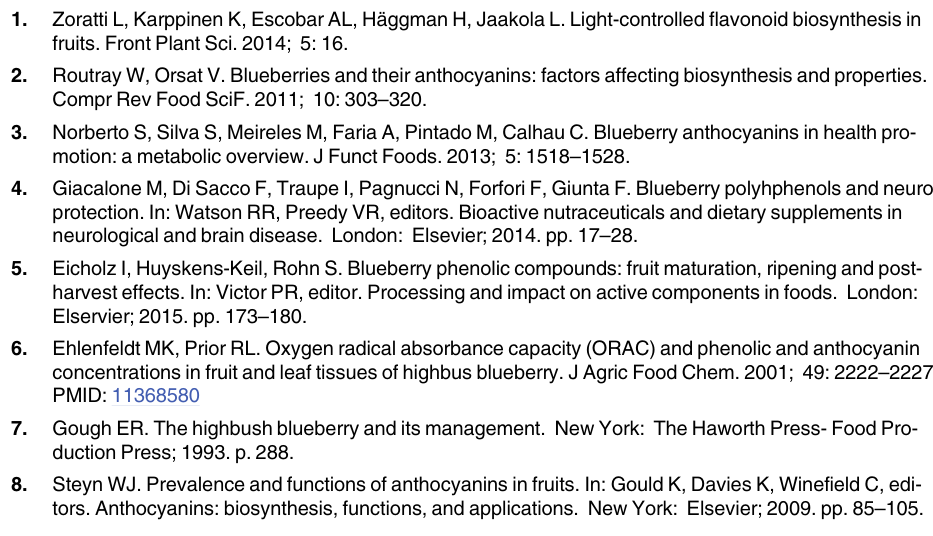
S2 Table. Light measurements taken at the top of the canopy every 2 nd hour between 9am and 3pm during the ripening period of berries (June 30, 2013). Measurements were done on clear sky sunny day. The quality of light reaching the plants was identified measuring the pho- tosynthetic active radiation (PAR; Photons/cm²/s) values between 200 – 850 nm for full light spectra, 280 – 320 nm for UVB, 280 – 380 nm for UVA, 380 – 495 nm for blue (B), 495 – 590 for green (G), 590 – 710 nm for red (R) and 710 – 750 nm for far-red (FR) components of the sun- light spectra. The ratios of B/R and R/FR were also calculated. S3 Table. Pomological analyses (single berry weight, diameter and height), total soluble solid content (TSSC) and acidity of berries at harvesting. S4 Table. Correlation between pomological analysis and the anthocyanin content in blue- berries (Pearson ’ s analysis). Correlations are significant when p < 0.05 and are marked with asterisk ( (cid:1)